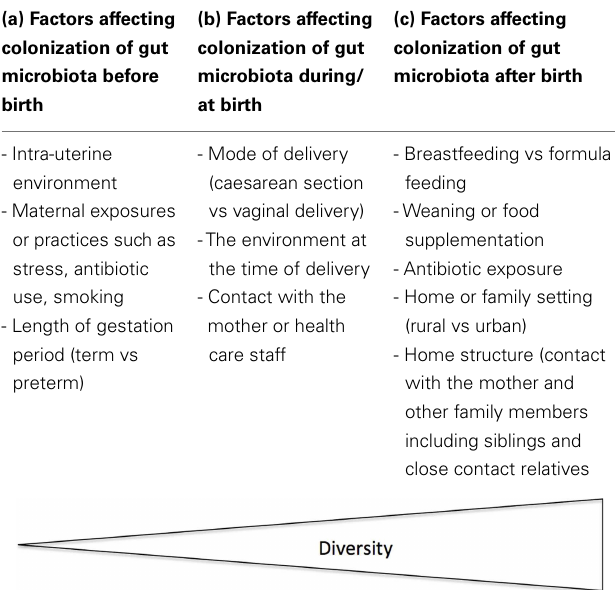
Table 1 | Summary of the factors affecting gut microbiota colonization in infants